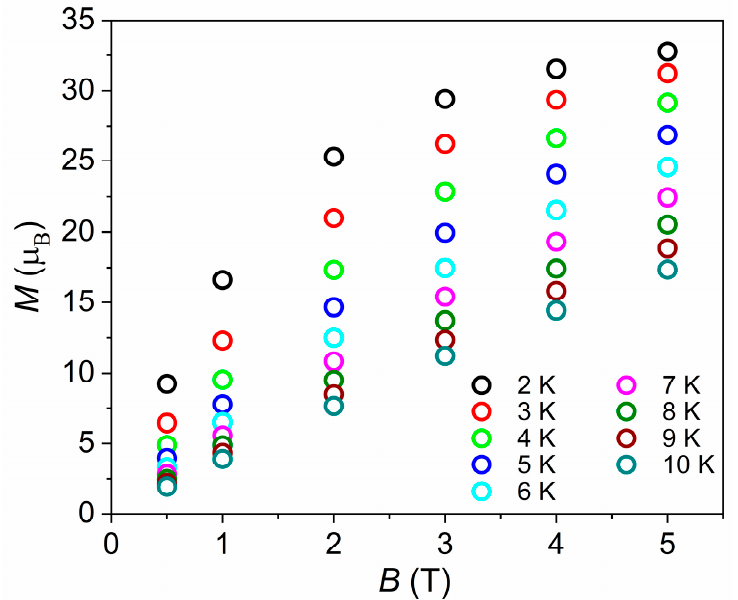
Figure 5. VTVB magnetisation data for ( 1 ) in the temperature and field ranges T = 2–10 K and B = 0.5–5 T.